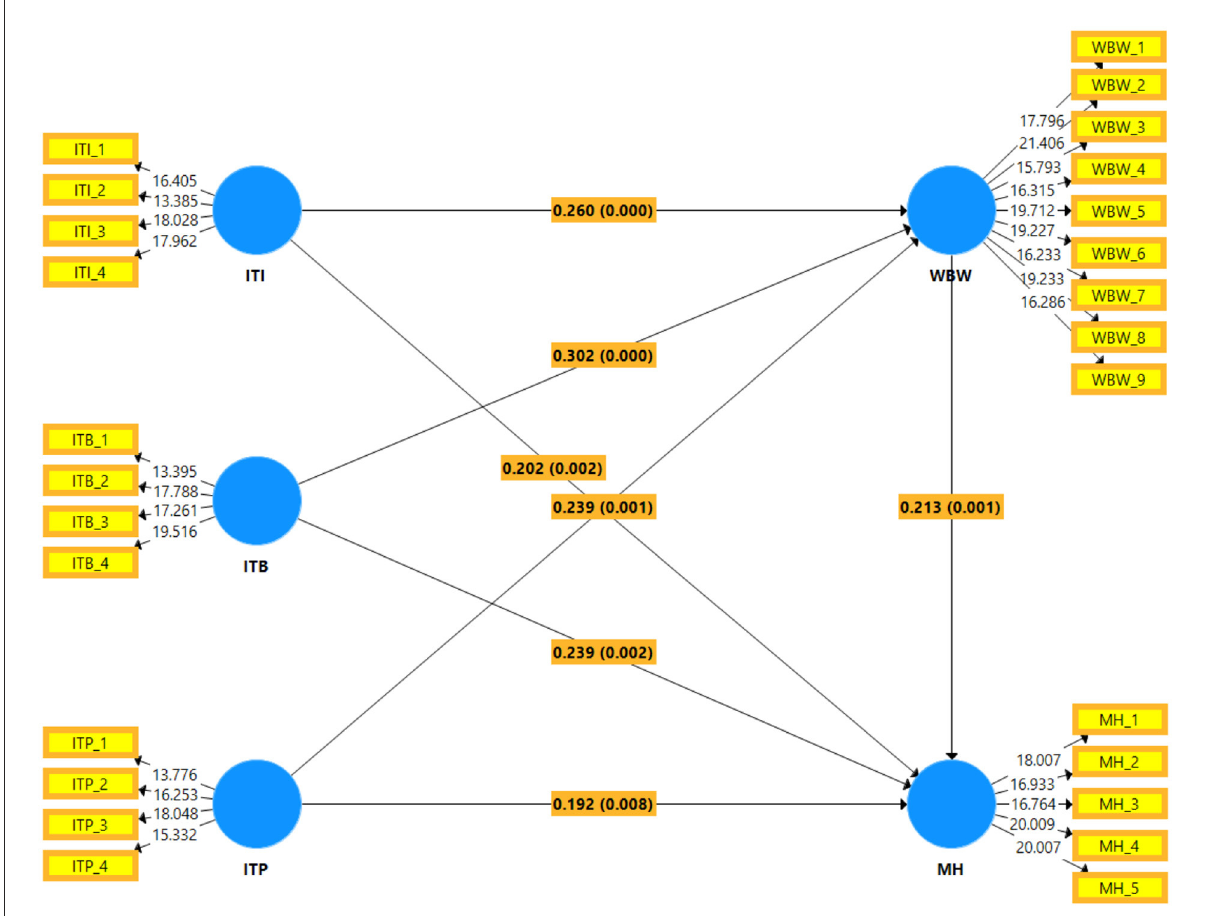
FIGURE3 Structural model PLS-SEM